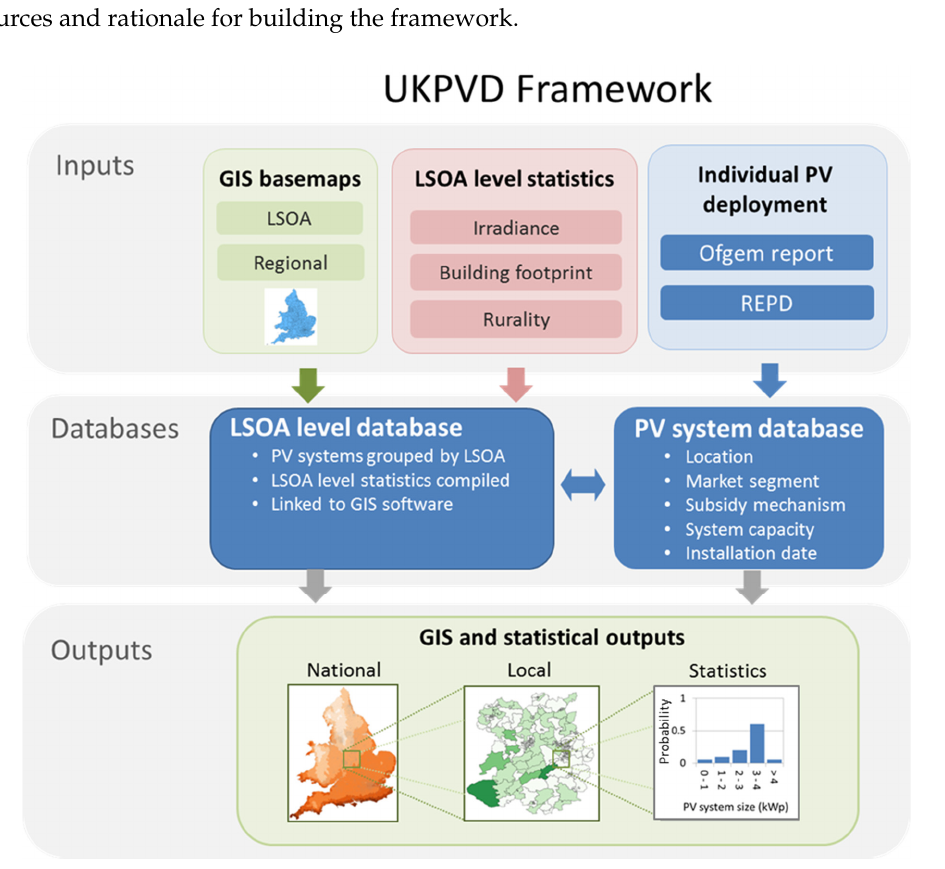
Figure 1. Schematic of the United Kingdom photovoltaics deployment (UKPVD) framework.